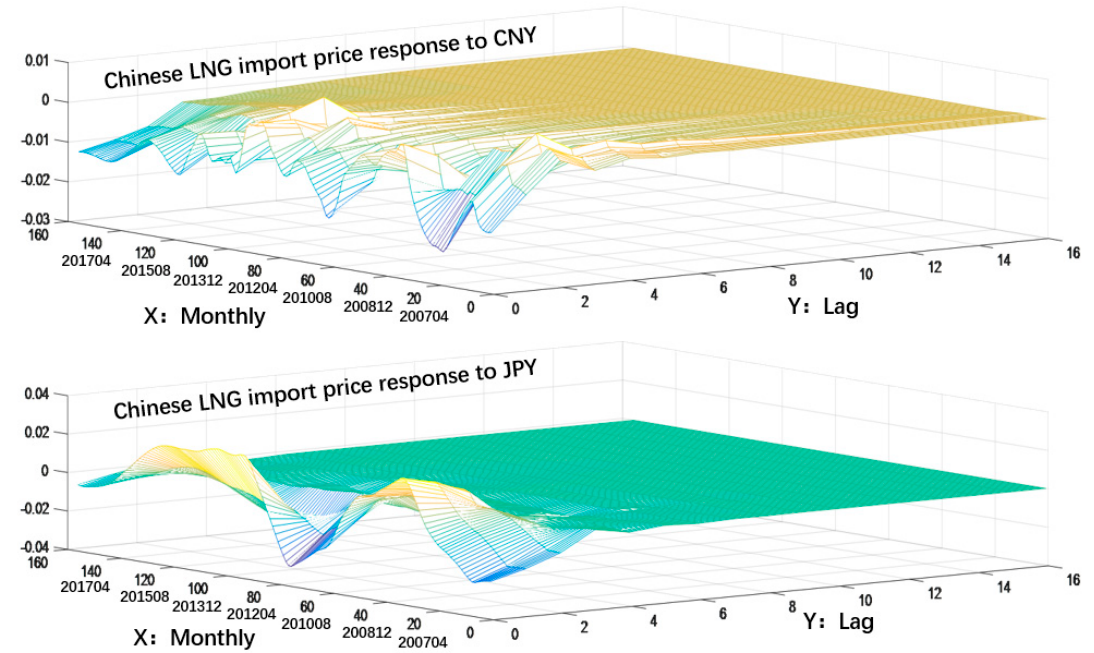
Figure 5. 3D impulse response functions. This is a 3D diagram created using MATLAB R2016a software. The upper part represents the impulse response function ( E1 → PL ) of the Chinese LNG import price for the CNY E1, and the lower part represents the impulse response function ( E2 → PL ) of the Chinese LNG import price for the JPY E2. The X-axis (year) represents each time point at the data period, the Y-axis (section) represents the time elapsed from the shock (0–16), and the Z-axis represents the response size (post-shock mean).